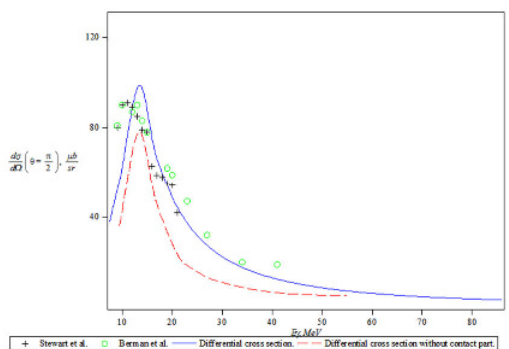
Figure 1. Dependence of differential cross section at θ =90° of photon energy. (cid:1)(cid:2)(cid:4)(cid:5), (cid:10)(cid:8)(cid:7) n(cid:9)